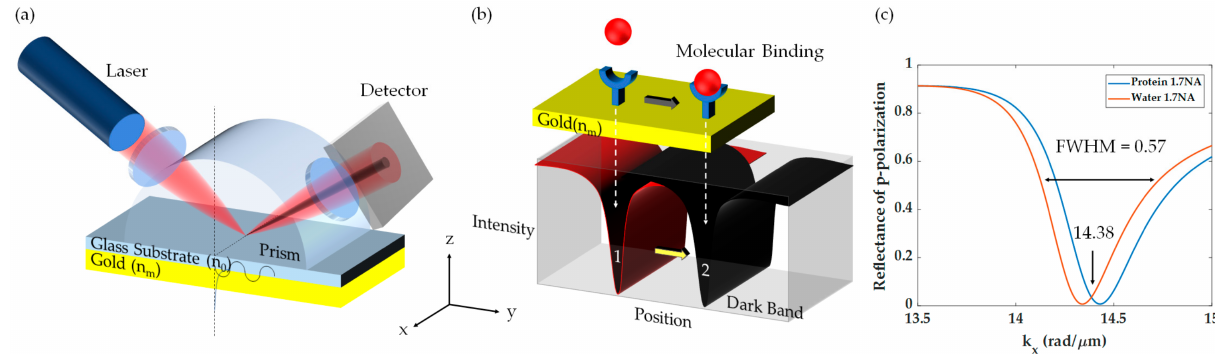
Figure 1. ( a ) Kretschmann configuration, ( b ) molecular binding and SPR reflectance spectra, and ( c ) SPR dips for bare gold 50 nm with water backing and the 10 nm uniform protein layer with a BSA protein refractive index of